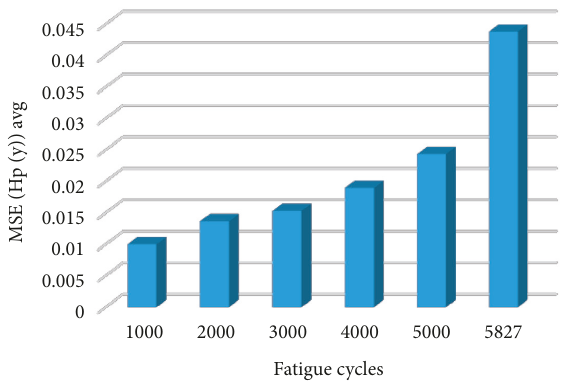
Figure 7: Mean value of H